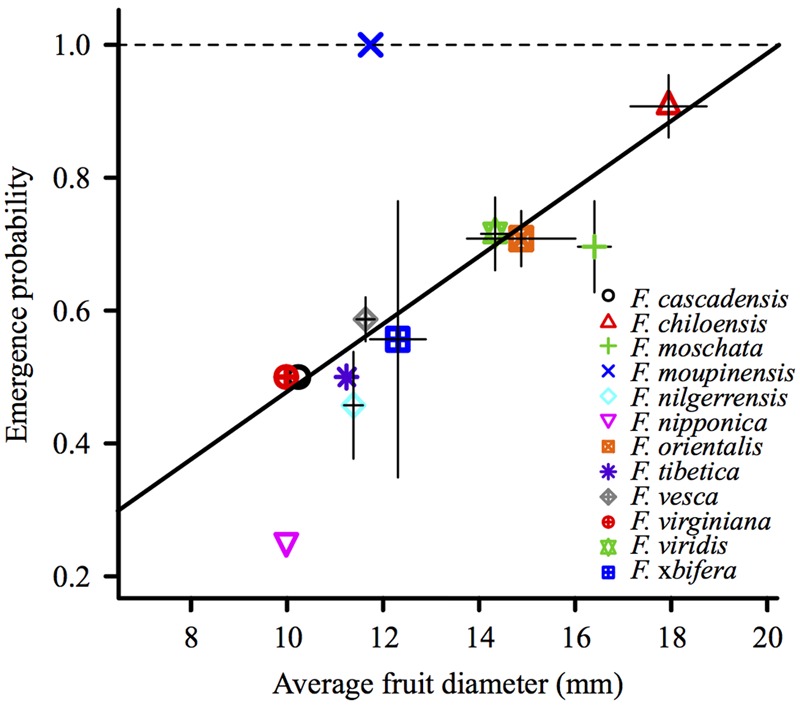
Emergence probability correlates positively with the average fruit diameter of Fragaria species (P = 0.024). Average fruit diameter of a species and average emergence probability were first averaged among the fruits of an accession, and then among the accessions of a species.